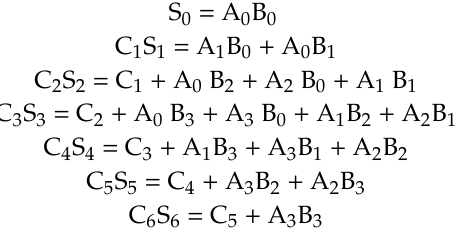
Figure 9. Block diagram of 4 × 4 Vedic multiplier.